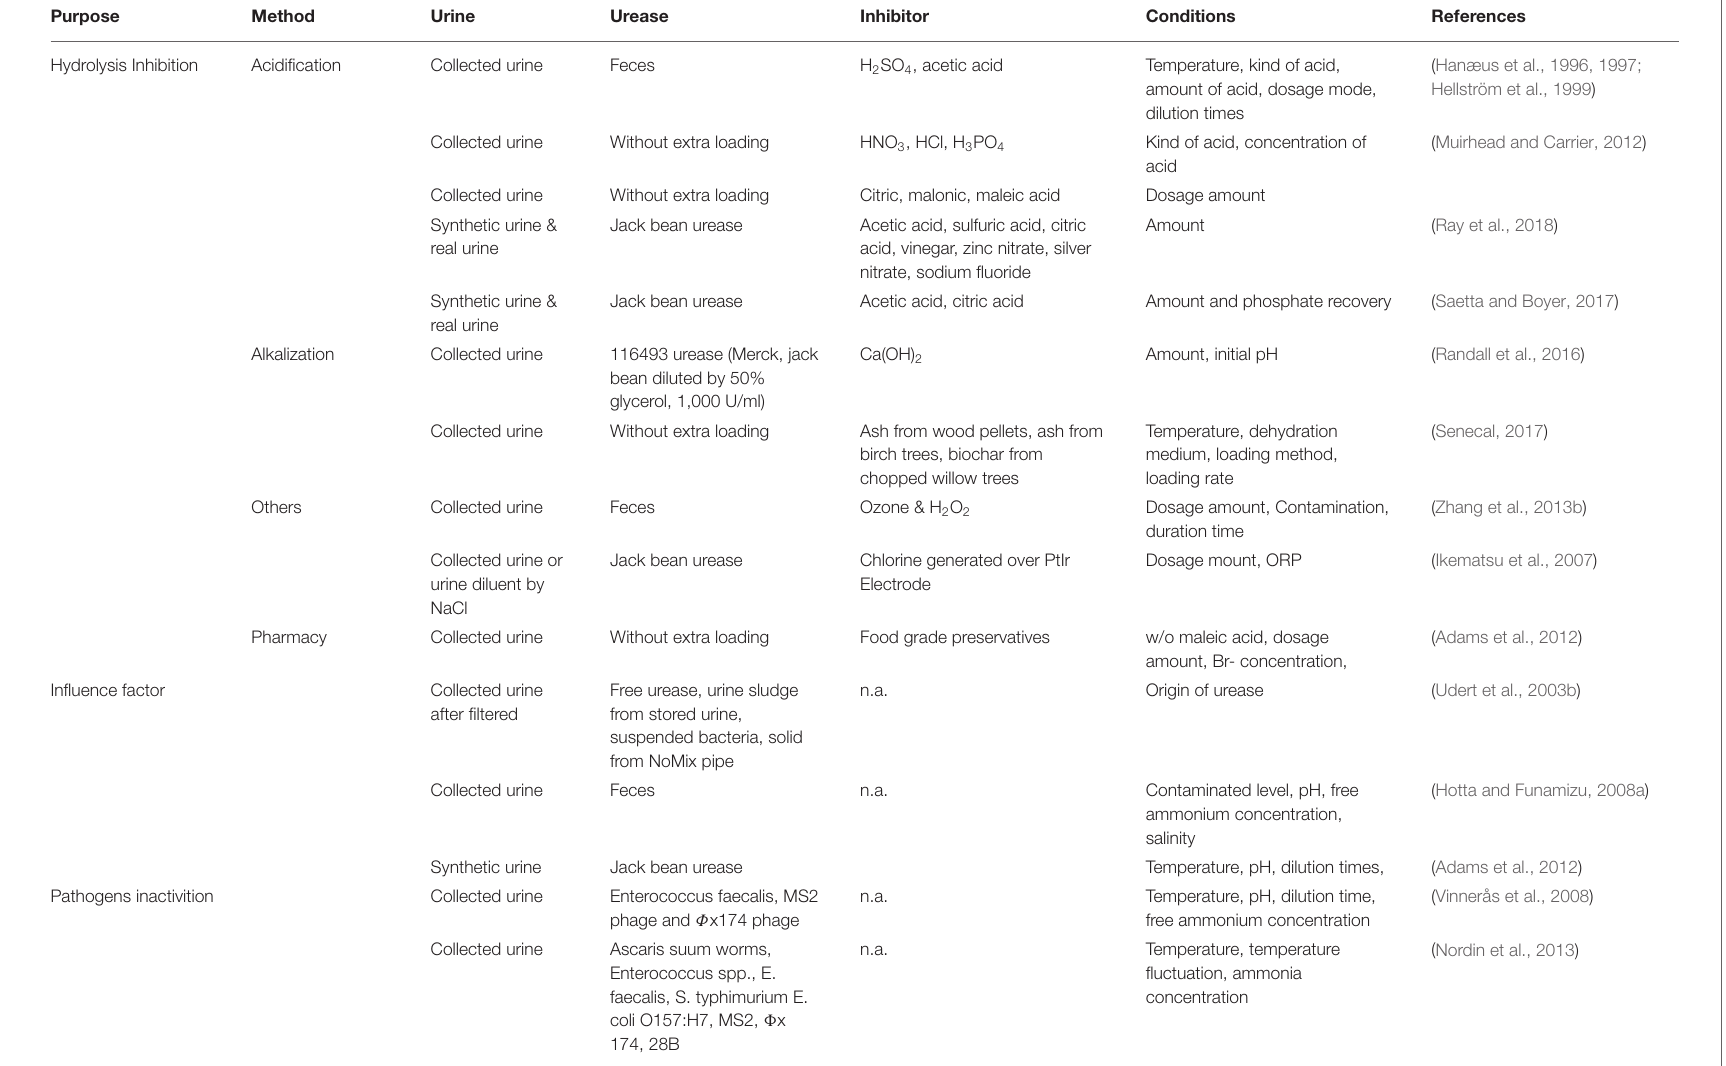
TABLE 1 | Examples of research literature on urine